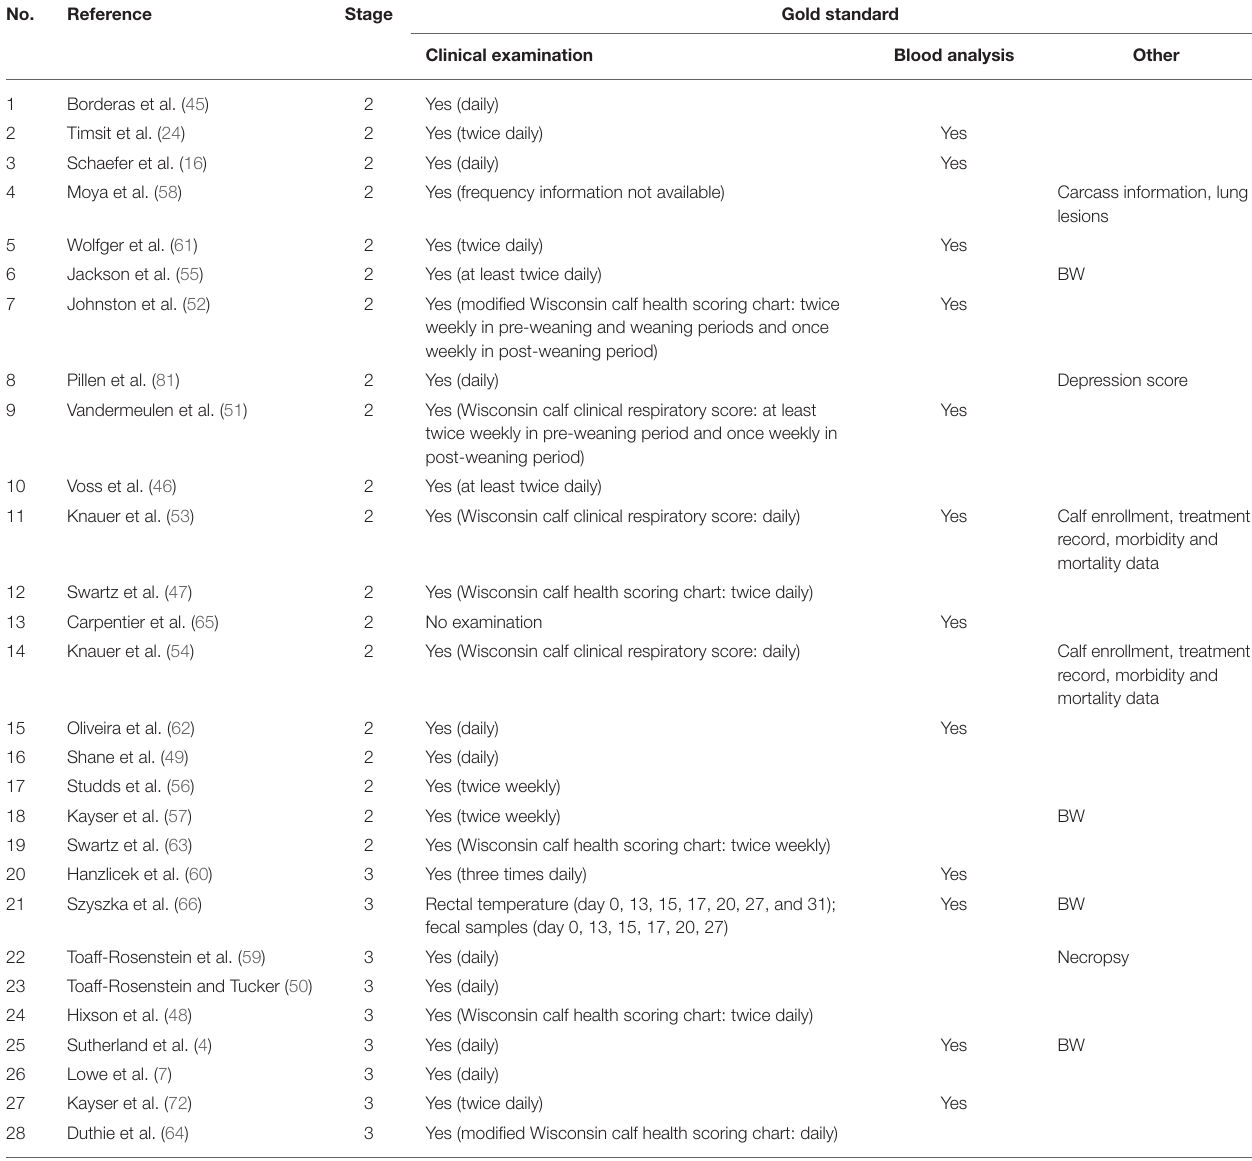
TABLE 1 | Gold standards of studies at stage two and three. No. Reference Stage Gold standard Clinical examination Blood